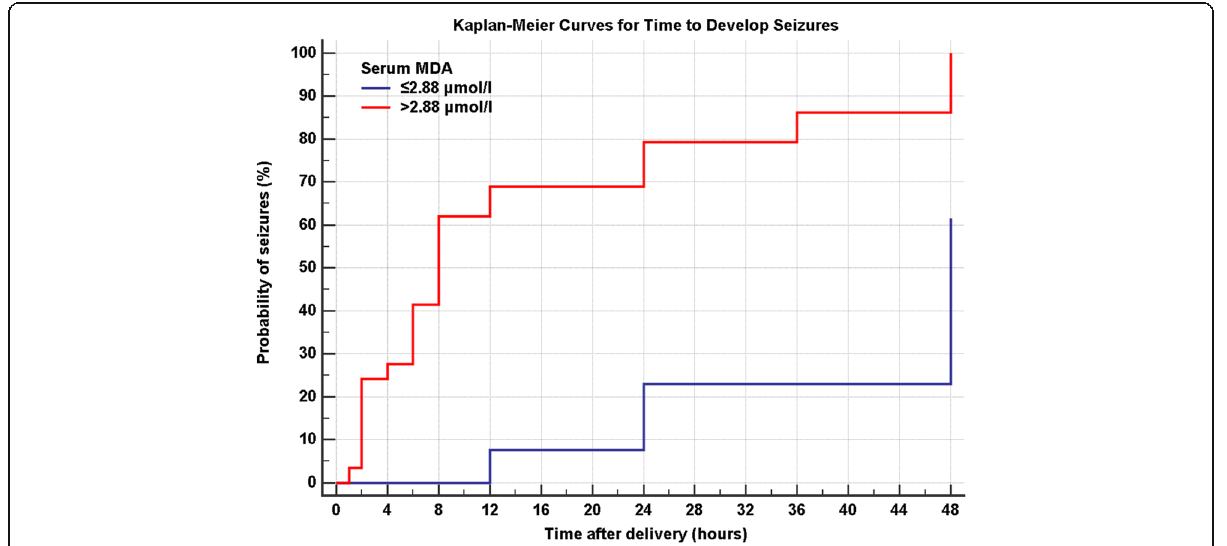
Fig. 3 Kaplan-Meier curves for time to develop seizures in patients with serum MDA ≤ 2.88 nmol/ml or > 2.88 nmol/ml